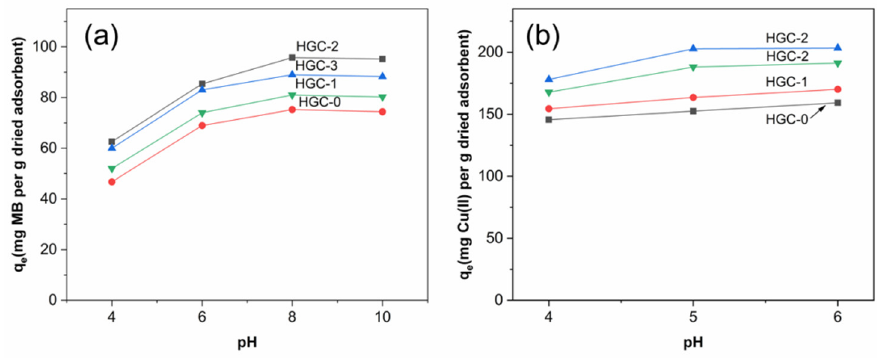
Figure 5. Effect of pH medium on sorption capacities of the various HGC beads with ( a ) MB and ( b ) Cu (II). Experimental conditions: 500 mg L − 1 initial Cu (II) concentration, 50 mg L − 1 initial MB concentration, and 100 mg dried beads under room temperature.